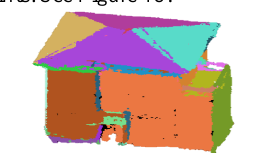
Figure 18. Detected facades for a ‘simple’ building.